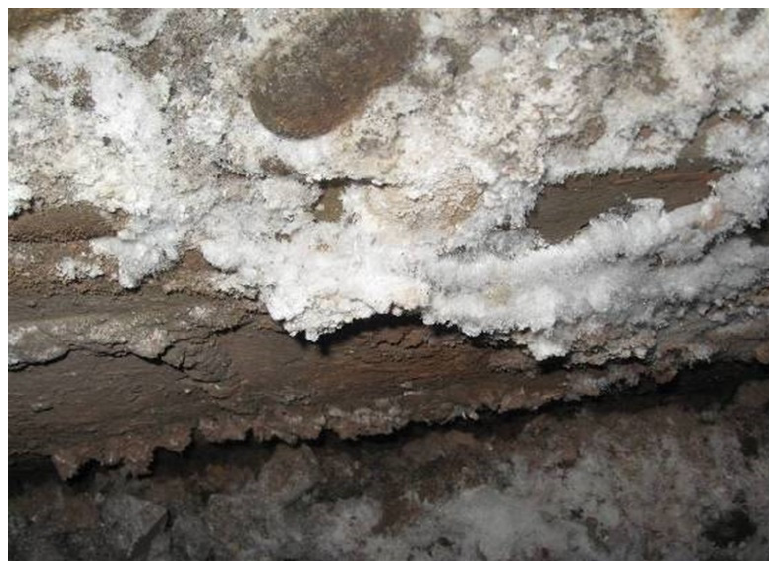
Figure 1. Sulfate attack of a tunnel lining in southwest China.